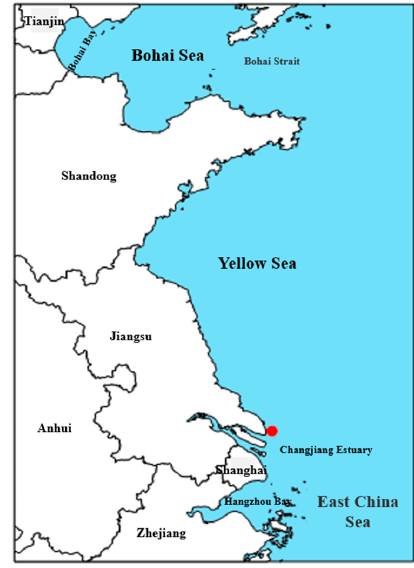
Figure 1. The area for obtaining the test